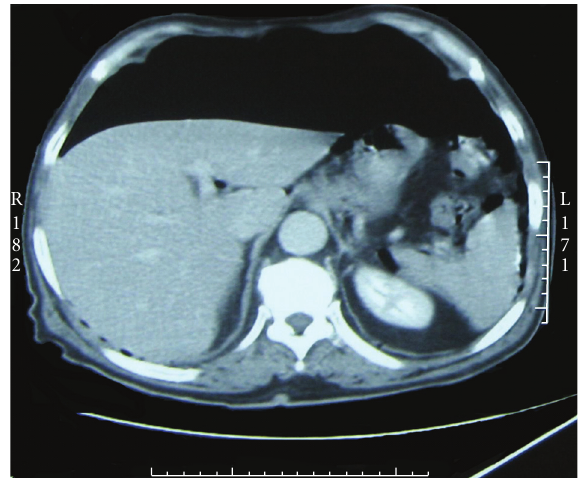
Figure 2: Abdomen CT with free intra-abdominal